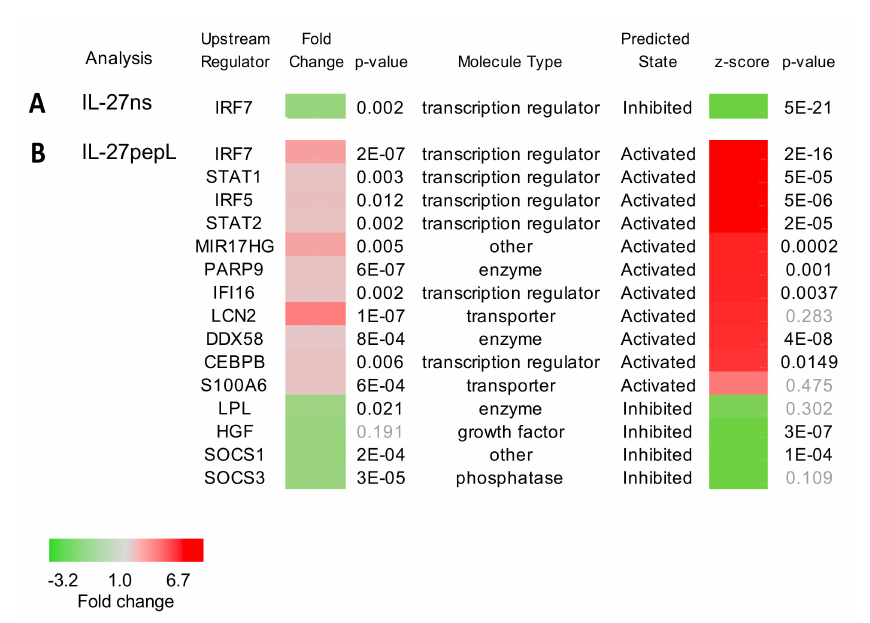
Figure 3. Upstream regulators predicted by IPA analysis of the dataset di ff erentially expressed for ( A ) IL-27ns and ( B ) IL-27pepL, each relative to pcDNA empty vector control. Shown are the upstream regulators actual gene expression fold change as assessed by RNAseq, and the p -value. Also shown are molecule types, and the IPA-predicted state (activated or inhibited), the z-score of the predicted state, and its p -value. Grey: insignificant p -values; color bar: fold